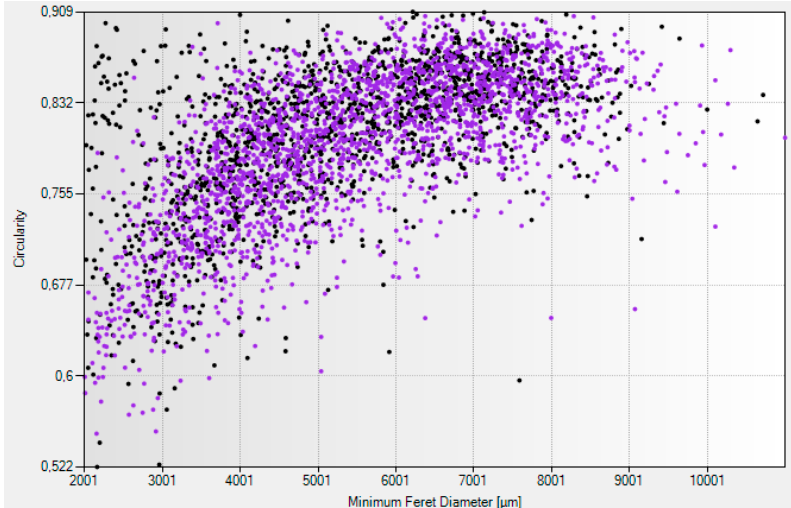
Figure 15. Distribution of the convexity index for irregular particle feed and its product from the bottom layer (I) in relationship to the particle size.